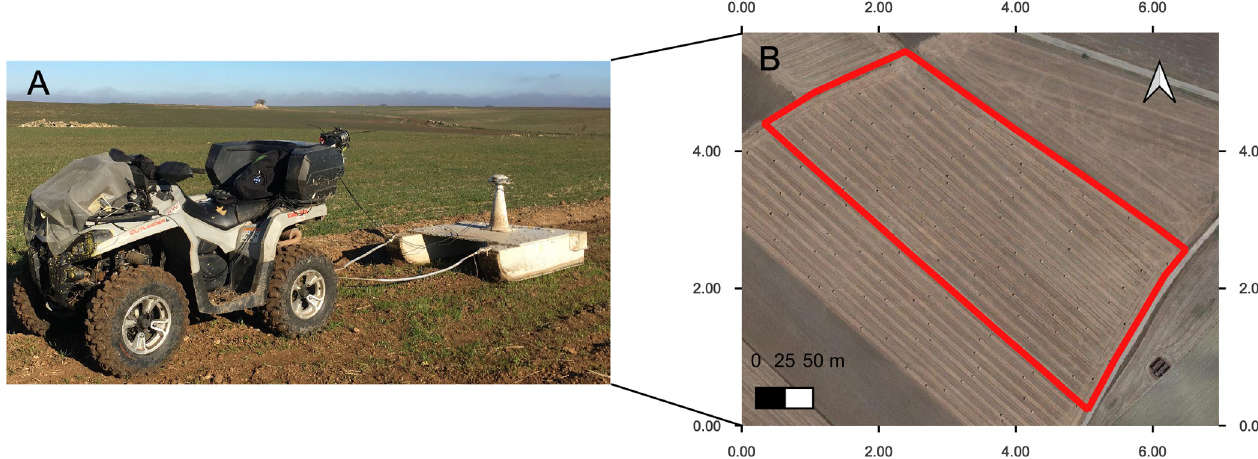
Fig 2. Soil spatial variability with electromagnetic induction technique. Low induction electromagnetic soil mapping (A, B), miniexplorer, GF Instruments (A), area tested by the instrument (B).